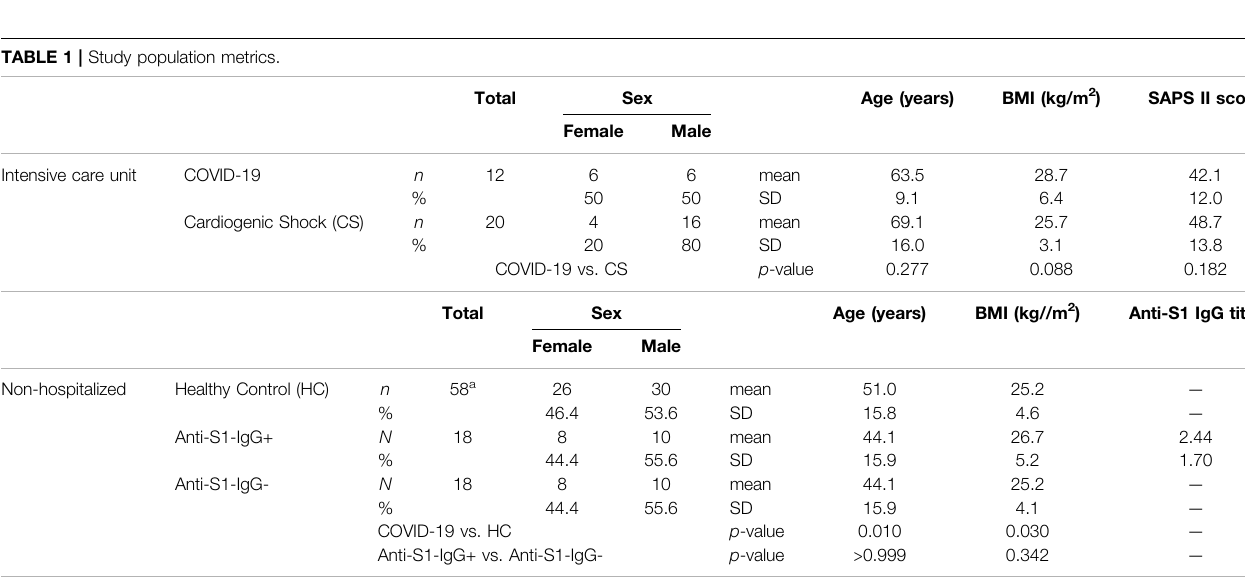
TABLE 1 | Study population